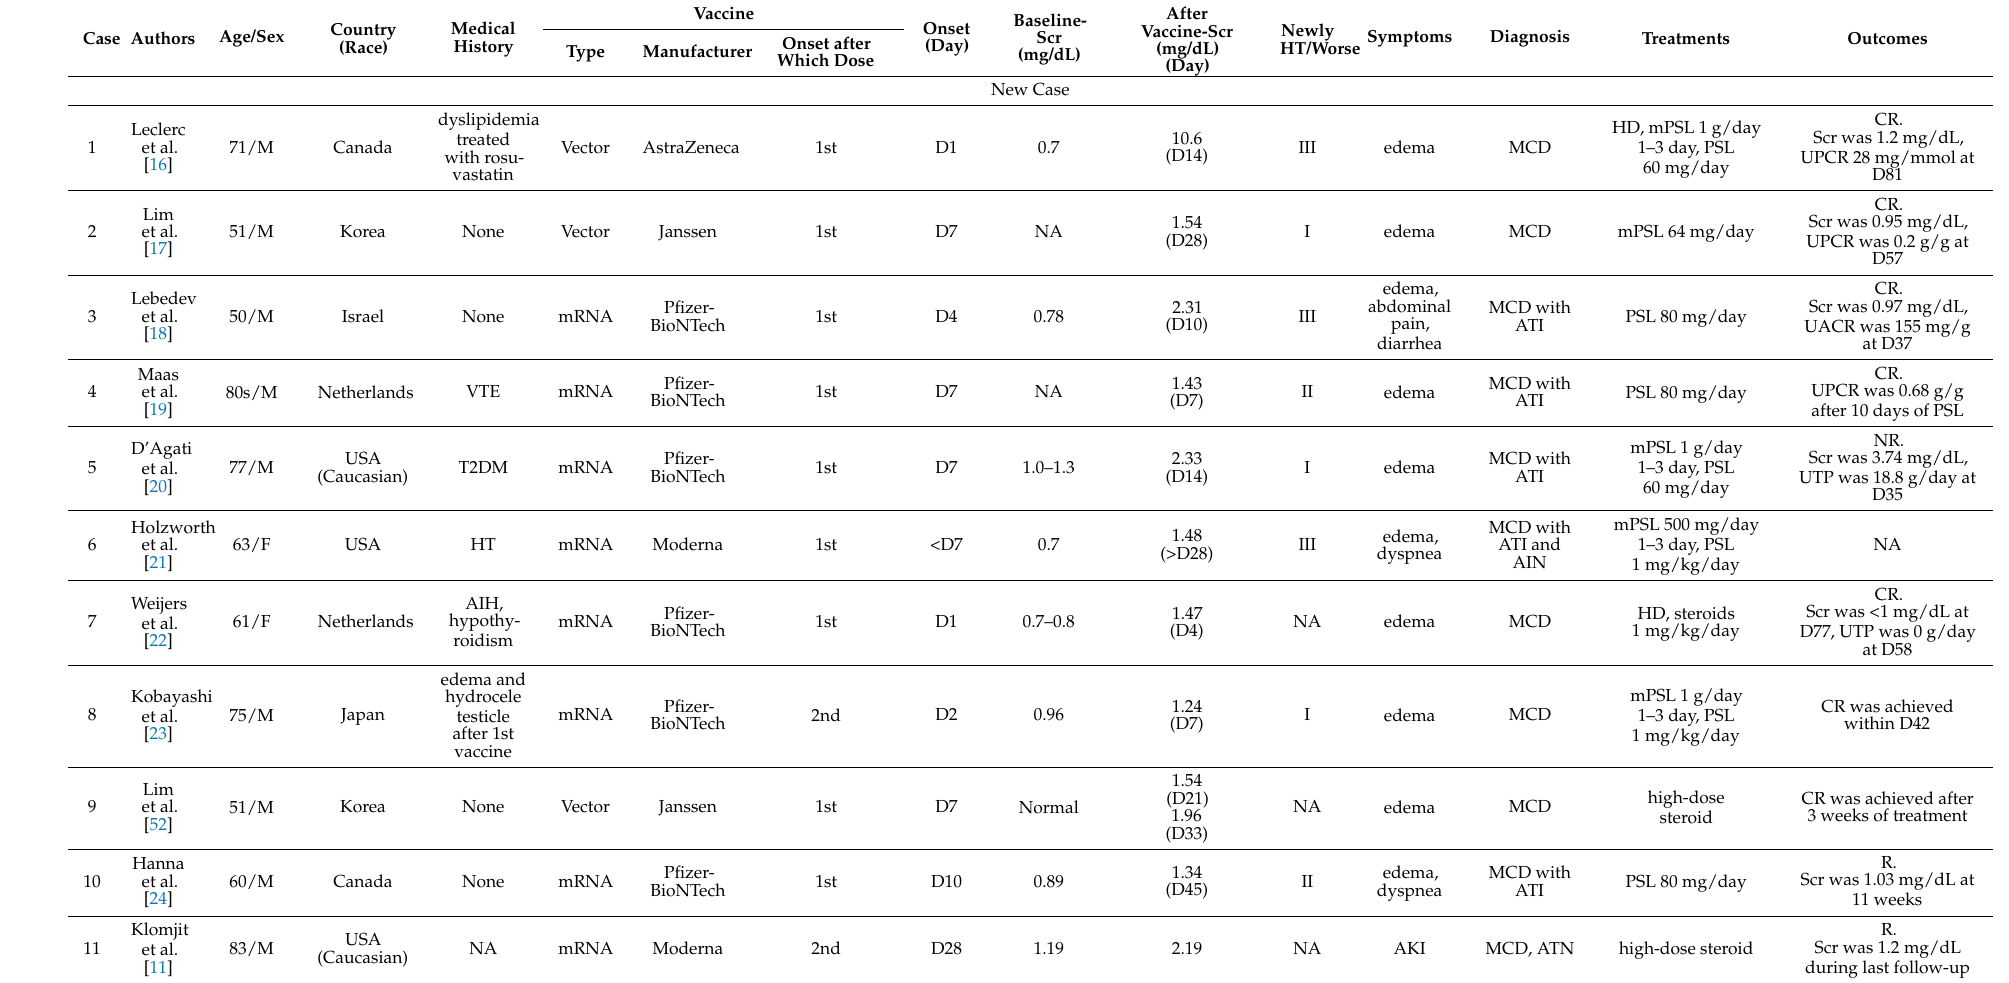
Table 1. Summary of published cases of newly diagnosed acute kidney